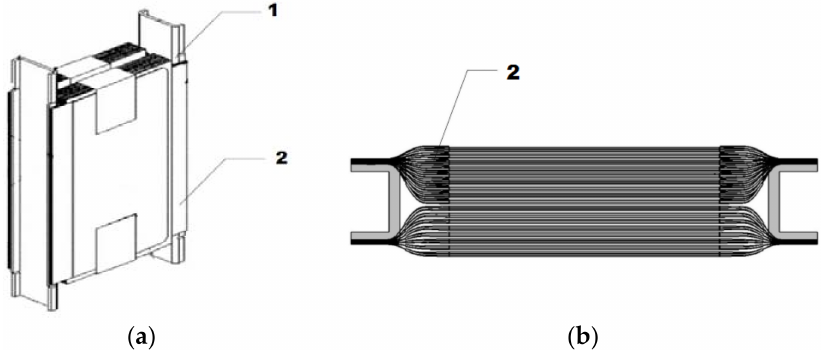
Figure 18. ( a ) A schematic diagram and ( b ) a cross-section view of a prismatic cell with 1: current collector and 2: tab